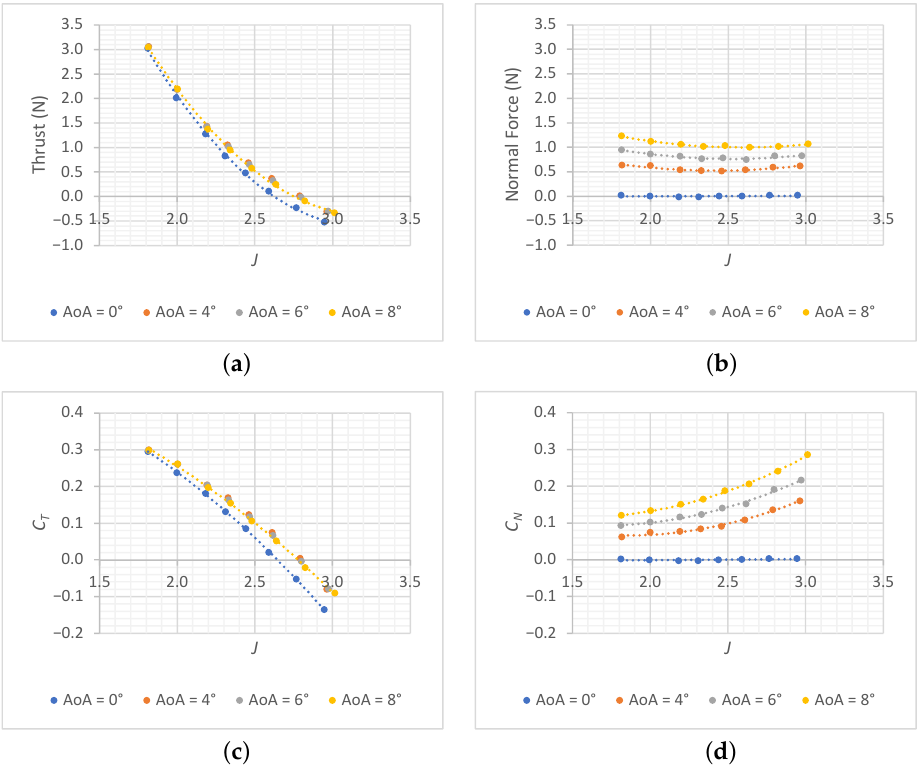
Figure 12. Experimental measurements of the effects of non-axial flow: ( a ) on propeller thrust; ( b ) on propeller normal force; ( c ) on propeller thrust coefficient; ( d ) on propeller normal force